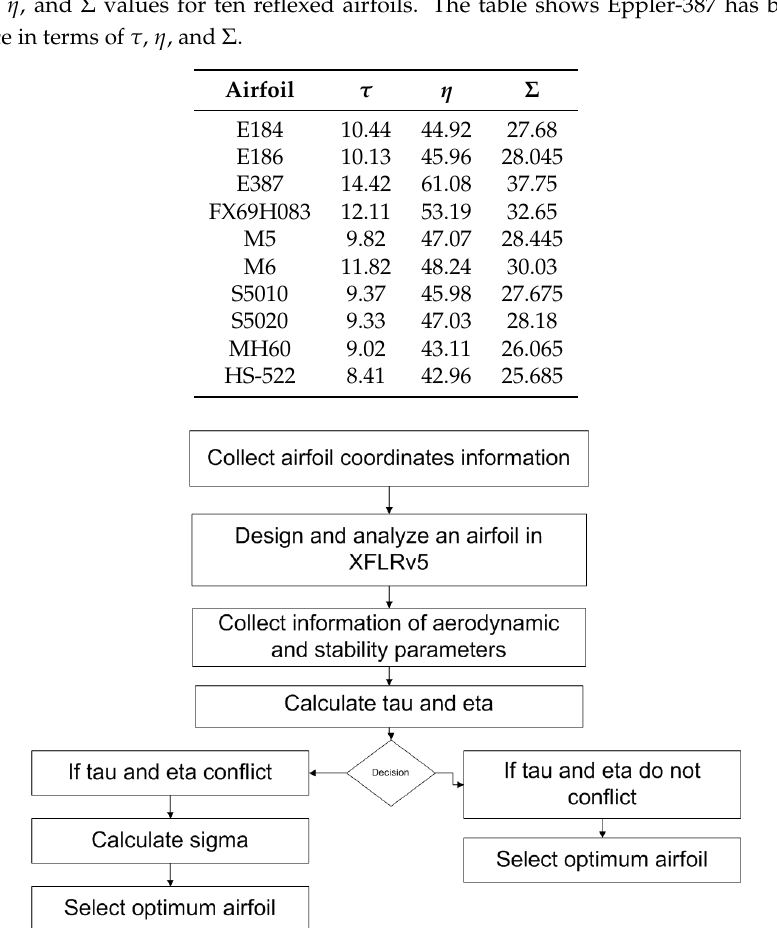
Figure 4. Flow chart of the proposed reflexed airfoil selection procedure for